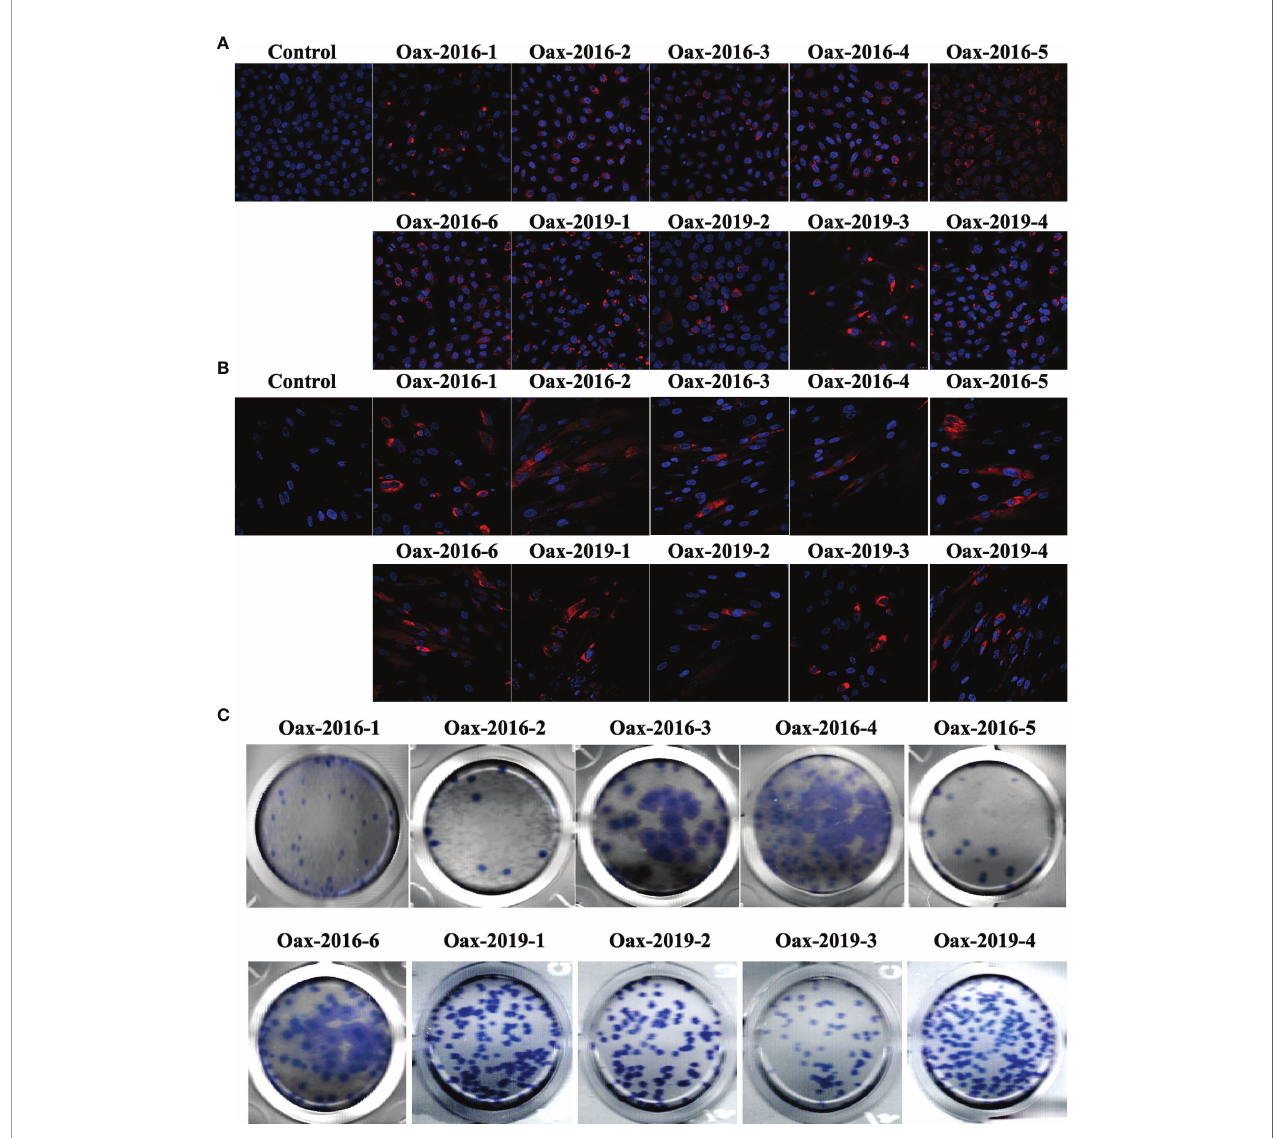
FIGURE 1 | Flavivirus isolate identi fi cation and quanti fi cation. Immuno fl uorescence of Vero (A) and HFF-1 (B) cells inoculated with supernatants of blind passages of diluted sera from positive samples. Cells were fi xed, permeabilized, and intracellularly stained with 4G2 monoclonal antibody followed by Alexa Fluor 546-conjugated secondary antibody. Non-inoculated cells were used as staining controls. (C) Plaque morphology of Flavivirus isolates. Supernatants of blind passages that were immuno fl uorescence positive were tittered in Vero cells, and plaque-forming units (PFUs) were immunostained with 4G2 monoclonal antibody followed by horseradish peroxidase (HRP)-conjugated secondary antibody. Finally, PFUs were developed with 3,3 ′ ,5,5 ′ -tetramethylbenzidine